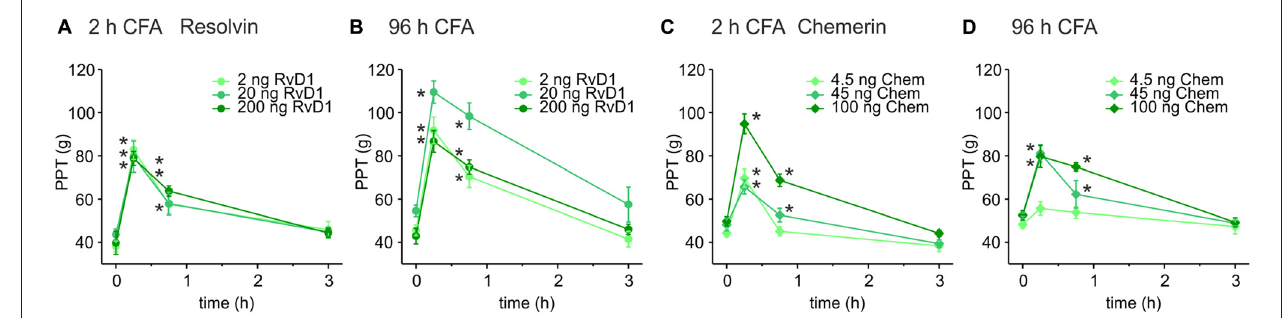
FIGURE 1 | Antinociception by resolvin D1 (RvD1) and chemerin (Chem) in early and late states of complete freund’s adjuvant (CFA)-induced hind paw inflammation in rats. Antinociceptive effects of RvD1 (A,B) and Chem (C,D) were measured in the early (2 h; A,C ) and the late phase (96 h; B,D ) of CFA-evoked hind paw inflammation in male Wistar rats. Mechanical hypersensitivity (paw pressure thresholds (PPTs); in g) was evaluated at indicated time points after intraplantar injection of RvD1 or Chem. Baseline values were obtained before injection of RvD1 or Chem. Dose-dependency was evaluated by injection of three different concentrations of RvD1 and Chem (see legends; n = 4–6 per group, mean ± SEM, two-way ANOVA RM post hoc Holm-Sidak, ∗ p < 0.05 vs. baseline pre-injection values, 0